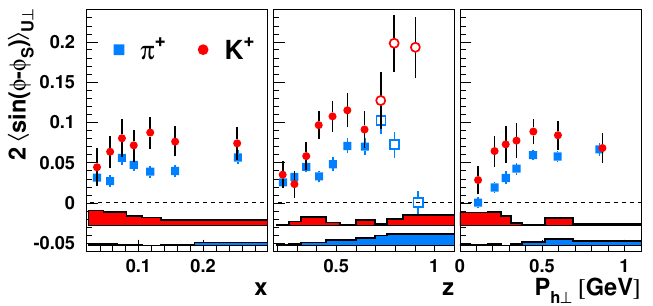
Figure 13 . Comparison of Sivers SFA for positive pions (squares) and kaons (circles) presented either in bins of x , z , or P h ⊥ . Data at large values of z , marked by open points in the z projection, are not included in the other projections. Systematic uncertainties are given as bands, not including the additional scale uncertainty of 7.3% due to the precision of the target-polarization